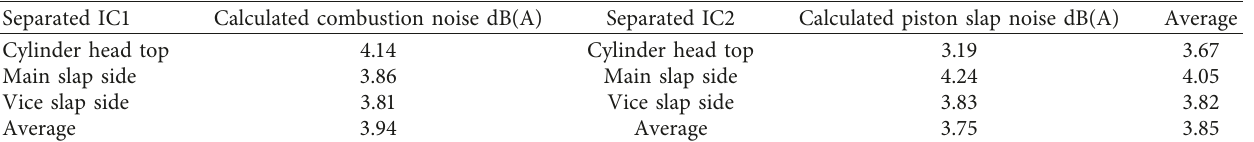
Figure 23: The calculated sound pressure level. (a) Cylinder head top combustion noise; (b) main slap side combustion noise; (c) vice slap side combustion noise; (d) piston slap noise. Table 6: The sound pressure level